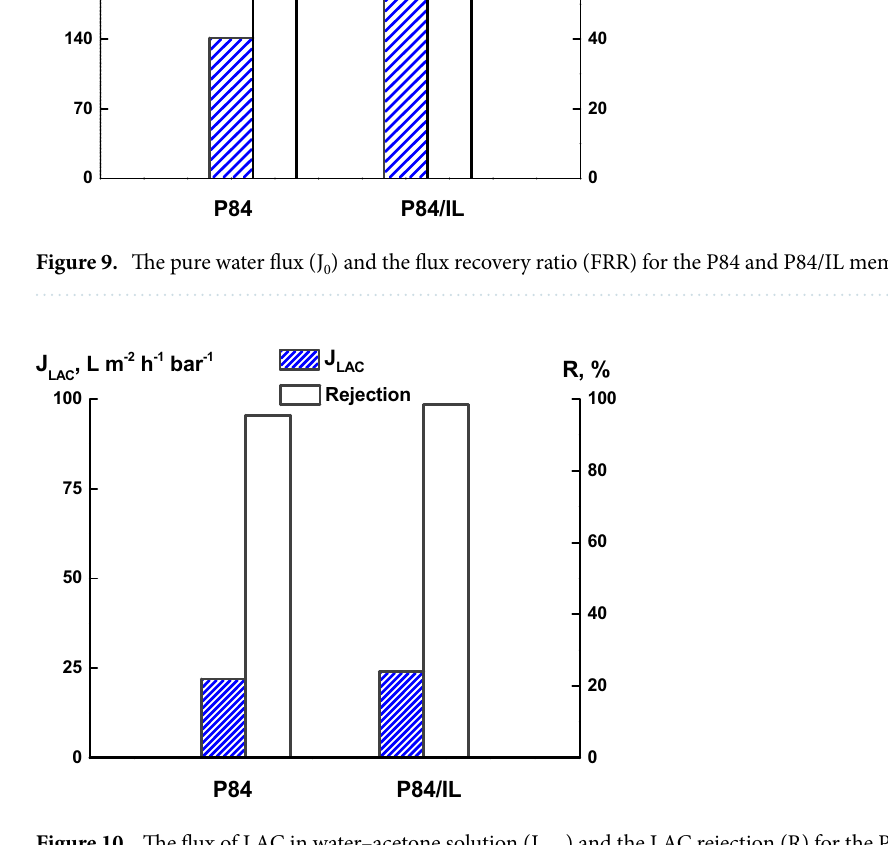
Figure 10. The flux of LAC in water–acetone solution (J LAC ) and the LAC rejection (R) for the P84 and P84/IL